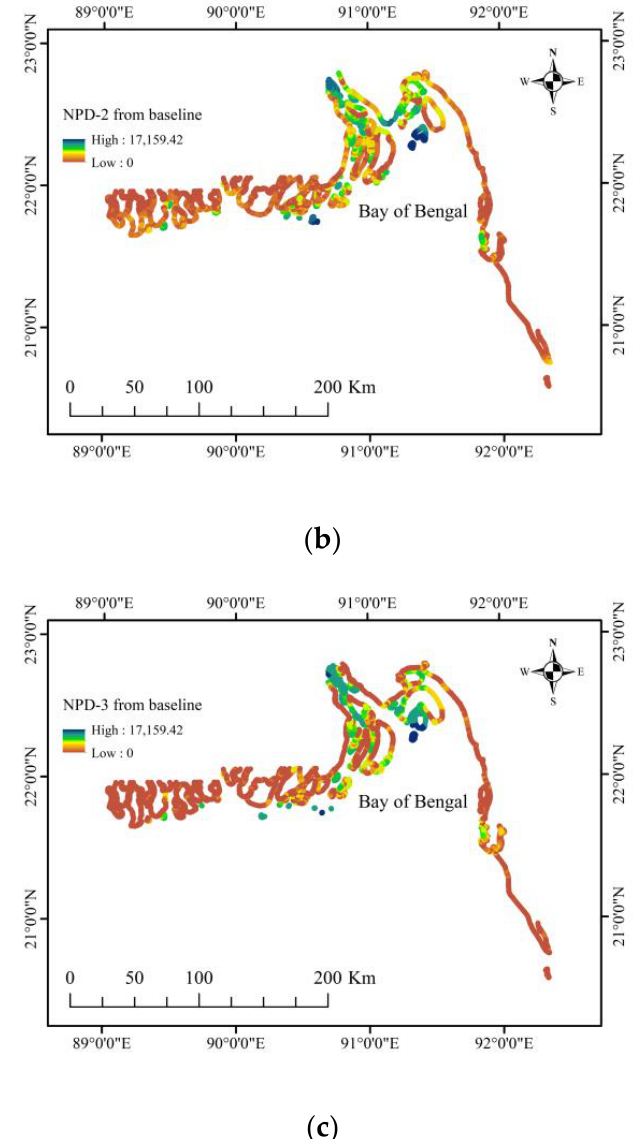
Figure 15. Near point distance (NPD) in meters using proximity analysis (baseline to the shoreline): ( a ) NPD-1 of 1991, ( b ) NPD-2 of 2006, and ( c ) NPD-3 of 2021.